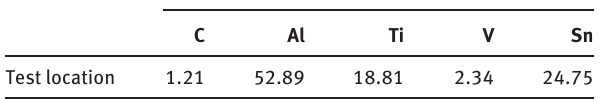
Table 1 EDS result of the location in the alloying